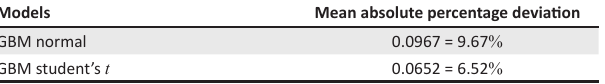
TABLE 3: Estimated parameters of the geometric Brownian motion normal and student’s t -distribution. TABLE 4: Evaluation statistic-distribution comparison of techniques based on the normal and student’s t . Models